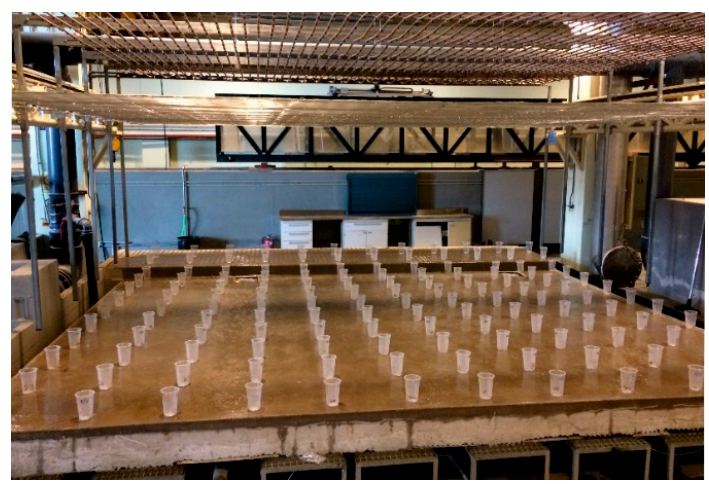
Figure 3. Vessels disposed over the entire model surface in a 0.5 m × 0.5 m grid to measure rain intensity and uniformity.